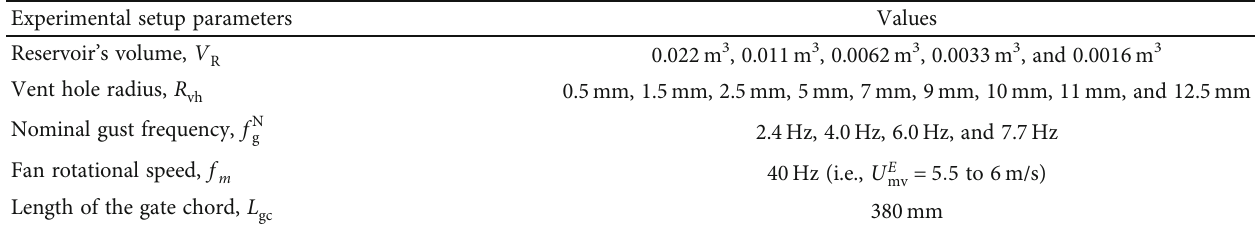
Table 1: Experimental setup.